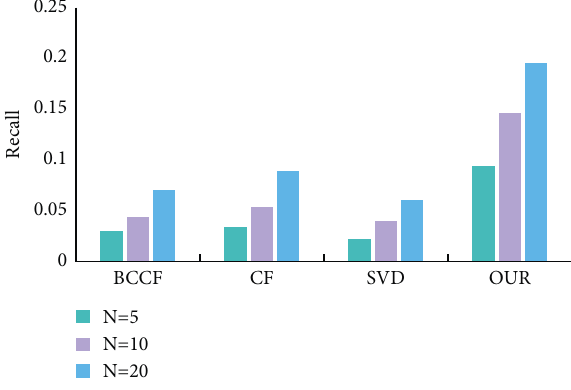
Figure 4: Comparison of recall on MovieLens latest.